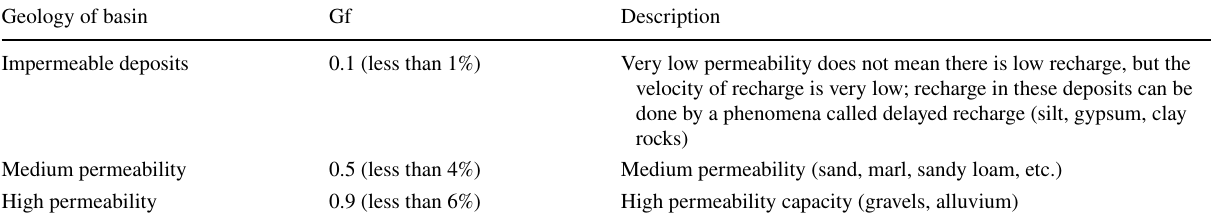
Table 2 Geological settings factor value for permeable, semipermeable and impermeable layers Geology of